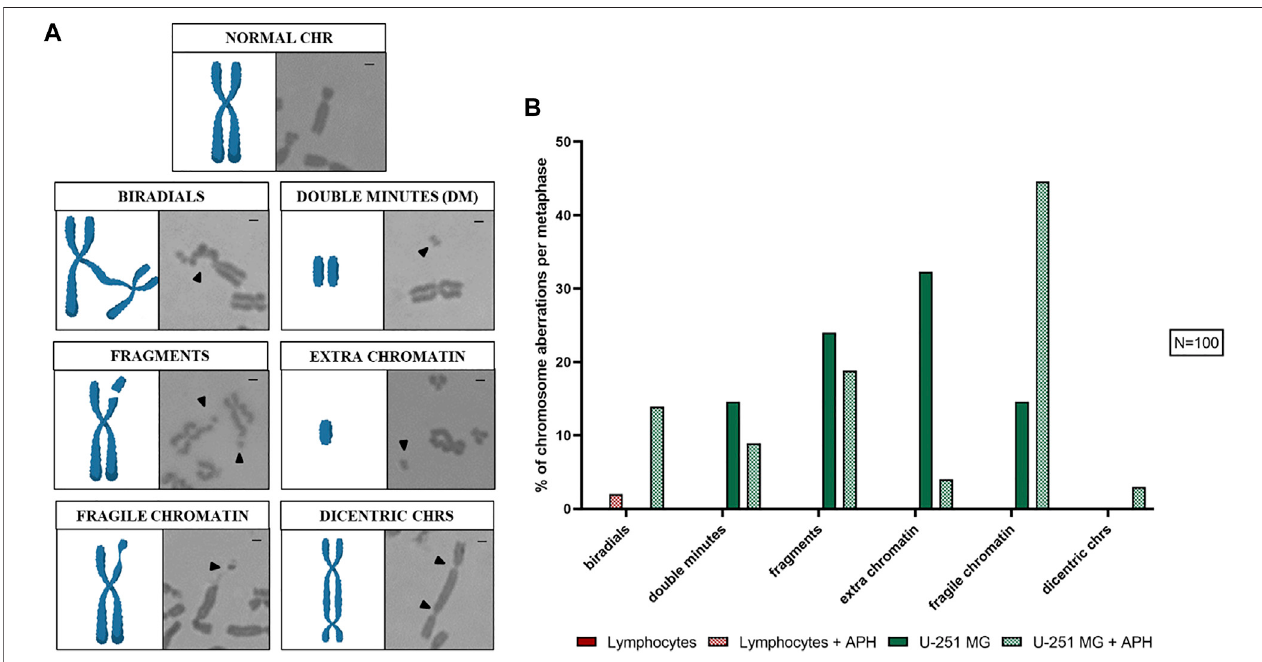
FIGURE3| Left:sub-condensedpericentromericregions(qh+)onchromosome1 (A) ,9 (B), and16 (C) .Right:percentageofeachqh+onchromosome1,9,and 16 in both lymphocytes and glioblastoma cells under the control and low APH conditions (D) . Black arrows indicate qh+ in Giemsa staining and white arrow the qh+ in Chromomycin A3 staining. Number of counted metaphases under control and APH-treated conditions was 100 ( N (cid:1) 100) for one replicate. CHR, chromosome. Scale bar: 1 µm.